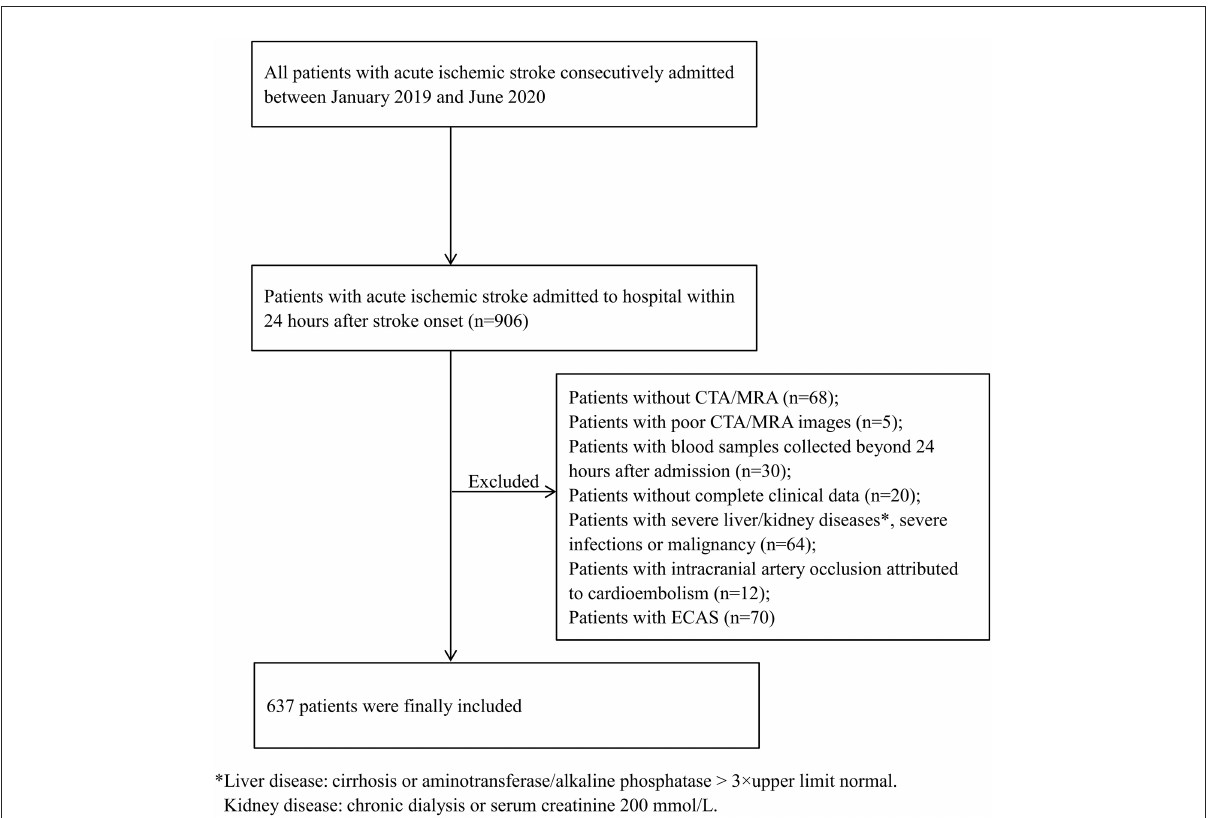
FIGURE1 Flow chart of patient selection in this study. CTA, computed tomography angiography; ECAS, extracranial atherosclerotic stenosis; MRA, magnetic resonance